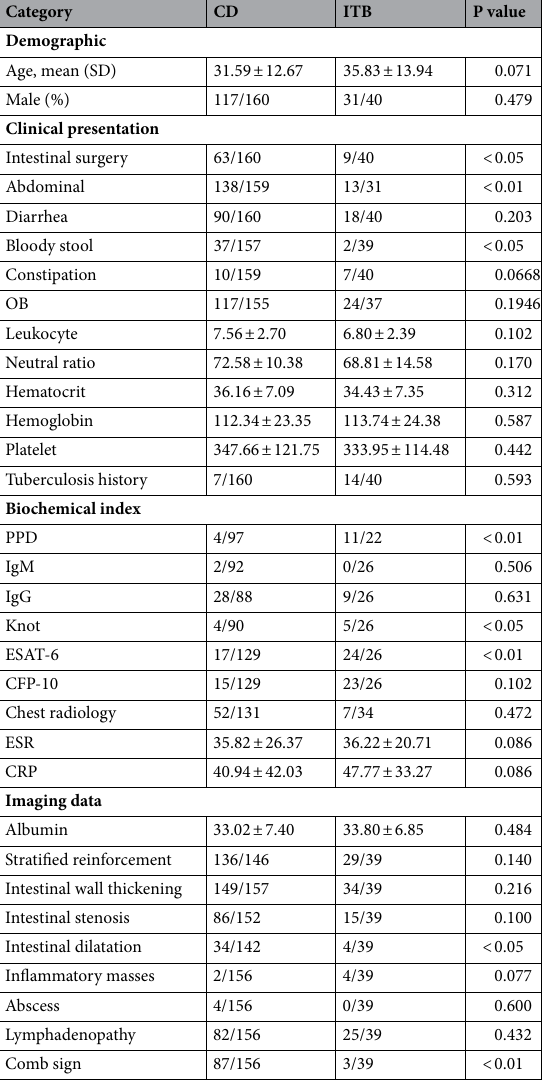
Table 1. Demographic characteristics, clinical presentation, laboratory test, imaging characteristics between CD and